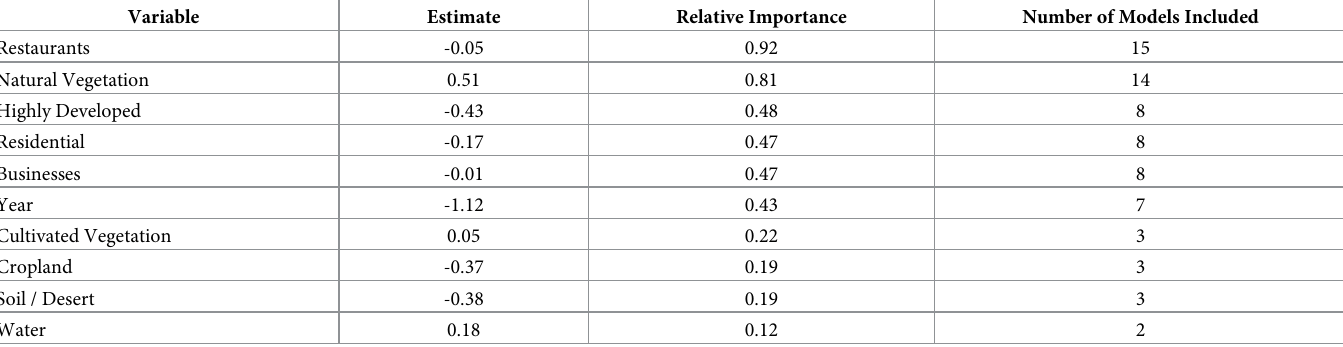
Table 3. Results from the model averaging (DAIC < 2) of the models investigating the relationship between community dissimilarity and variables of interest dur- ing the winter. Model averaged conditional beta estimates as well as relative importance and the number of top models the variable was included in. The variables are listed by relative importance.